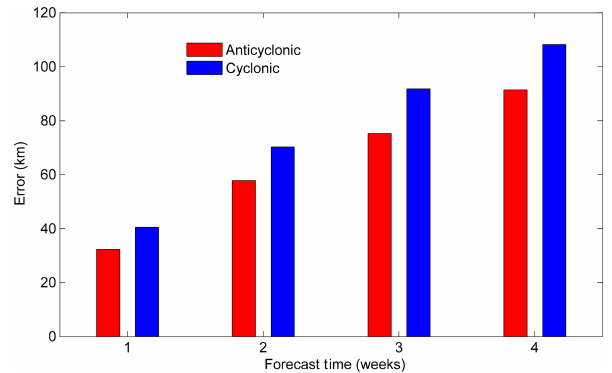
Figure 6. Comparison of the mean forecast errors between anticy- clonic eddies (red) and cyclonic eddies (blue) over a 4-week win-